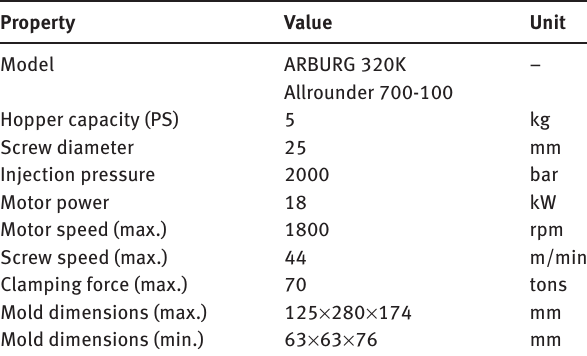
Figure 1 Neat PC and PC-MWNT Masterbatch mixture in the hopper.